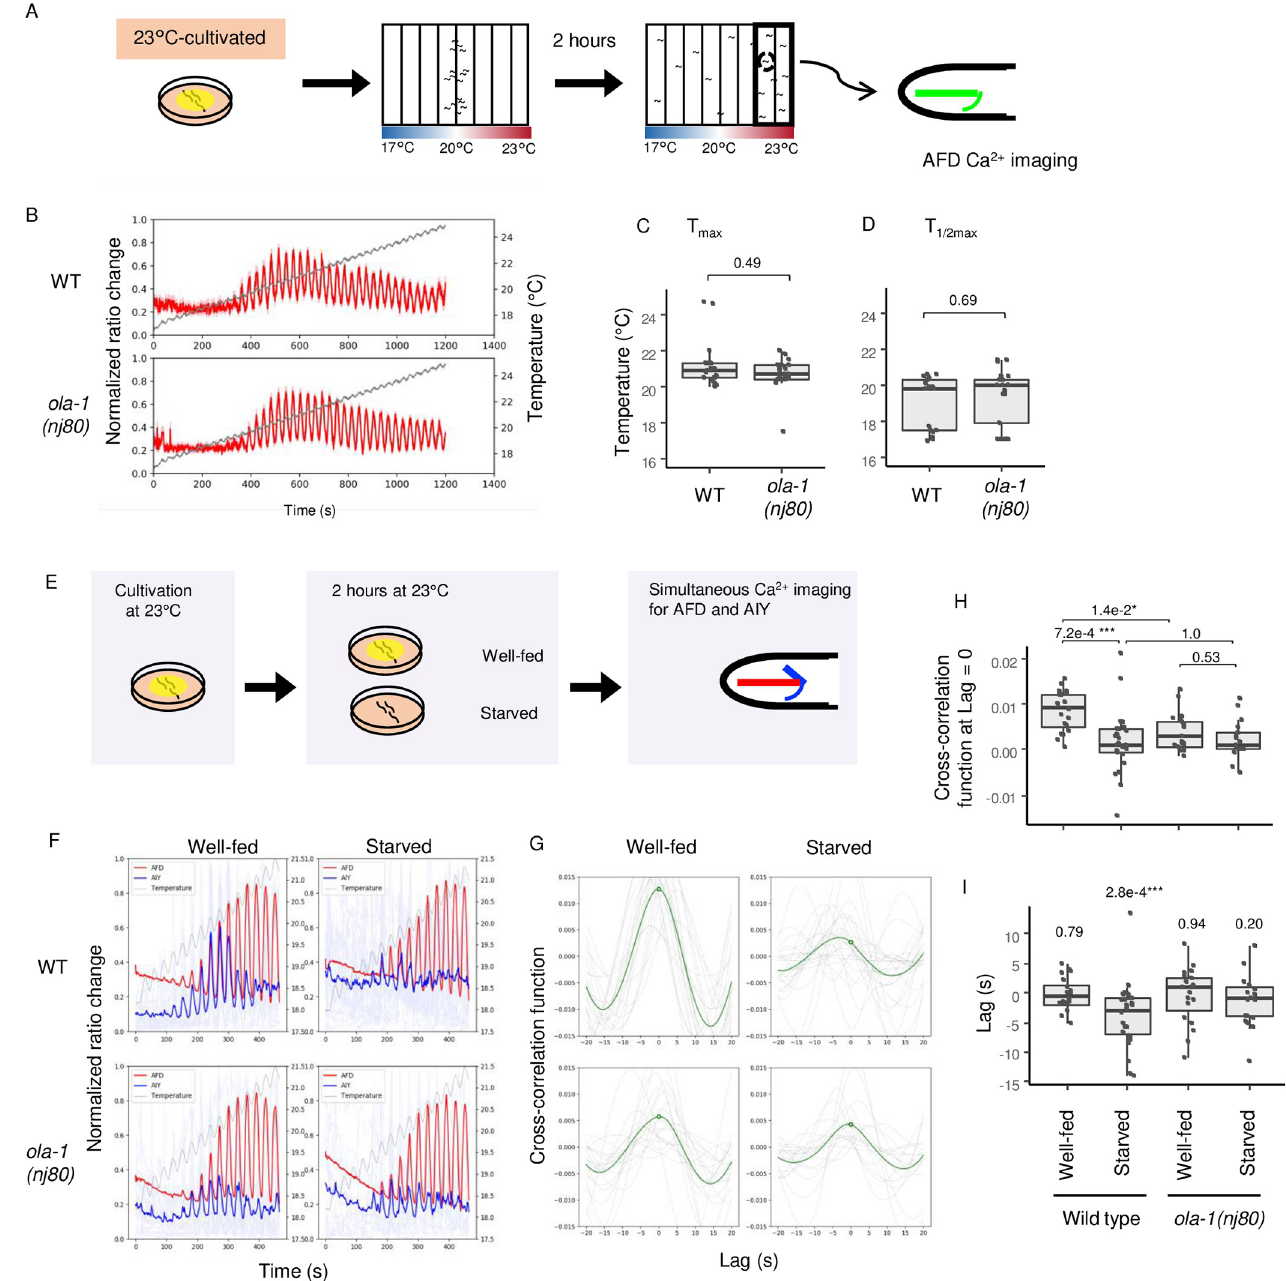
Fig 6. OLA-1 modifies synchrony between AFD and AIY after starvation. (A-D) Wild type and ola-1(nj80) animals expressing GCaMP3 and tagRFP in AFD were cultivated at 23˚C and allowed to freely migrate on a thermal gradient for 2 hours. Animals were then collected from sections 7 and 8, immobilized and subjected to Ca 2+ imaging analysis with the indicated temperature stimulus warming from 15˚C to 24˚C with oscillation (B). The ratio of green to red fluorescence of each trial was normalized from zero to one, and the mean values of normalized ratio were plotted (B). Shadow represents the SEM. Data were collected from distinct animals. Temperature at which moving average of the normalized ratio change with 5 sec of window showed the maximum (C) and the half maximum for the first time (D) were plotted. n = 17, 21. p values were indicated (Wilcoxon rank sum test). (E-I) Wild type and ola-1(nj80) animals expressing GCaMP3 in AIY and XCaMP-R in AFD were cultivated at 23˚C, transferred to NGM plates with or without food and incubated at 23˚C for 2 h. Animals were then immobilized and subjected to Ca 2+ imaging analysis with the indicated temperature stimulus warming from 18˚C to 21˚C with oscillation (F). The ratio of green or red fluorescence of each trial was normalized from zero to one. The mean values of the normalized fluorescence signals of AFD and AIY were shown with solid lines in red and blue, respectively. Light-colored lines represent individual data of AIY. Dashed oscillatory curves represent mean values of the thermal stimuli (F). Data were collected from distinct animals. (G) Mean and individual values of cross-correlation function between AFD and AIY were plotted against time lag. Solid green curves indicate the mean values, and gray curves indicate the individual data. Circles indicate values of the mean